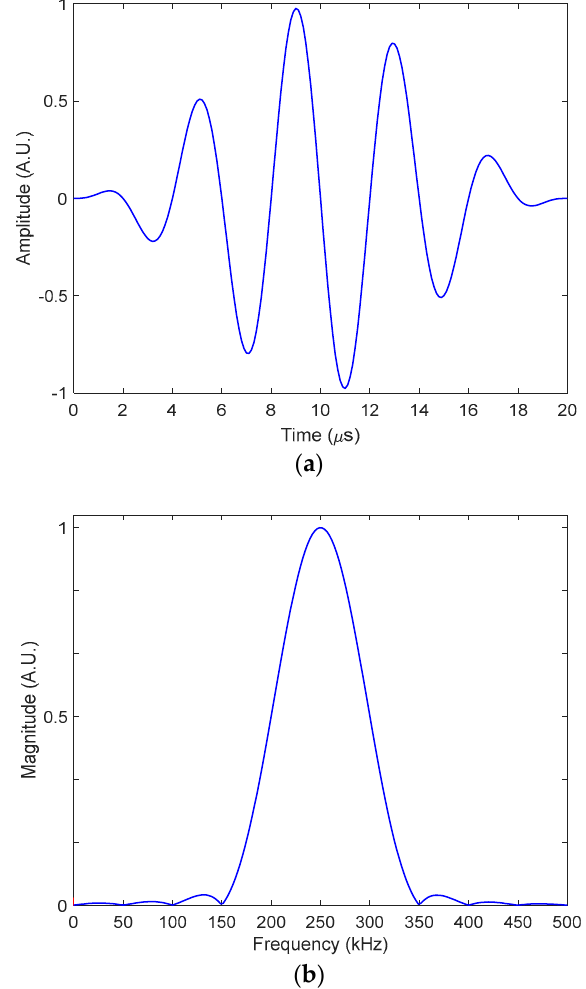
Figure 3. Diagnostic excitation with center frequency of 250 kHz: ( a ) time trace and ( b ) frequency spectrum.